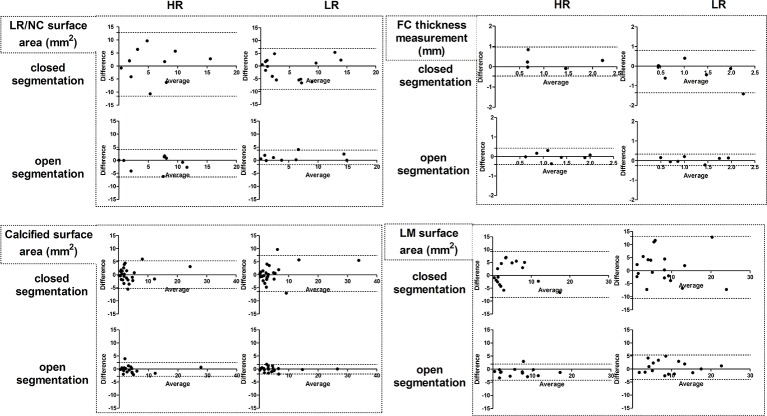
Bland-Altman plots of the high resolution and low resolution carotid plaque composition measurements for all parameters and for the open and closed segmentation method.The middle dashed line of each plot indicate the bias. The upper and lower dashed line indicate the 95% limits of agreement.